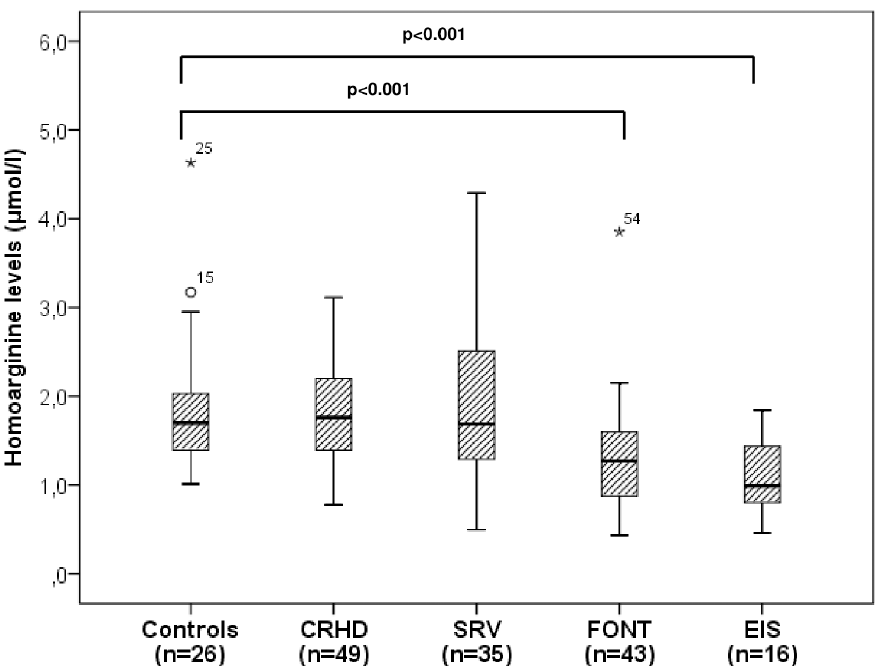
Fig 1. Boxplots displaying homoarginine levels in healthy controls and patients with various types of complex heart defects. CRHD, corrected congenital right heart disease;SRV, systemic right ventricle; FONT, Fontan palliation;EIS, Eisenmenger physiology or unrepaired cyanotic heart defect.